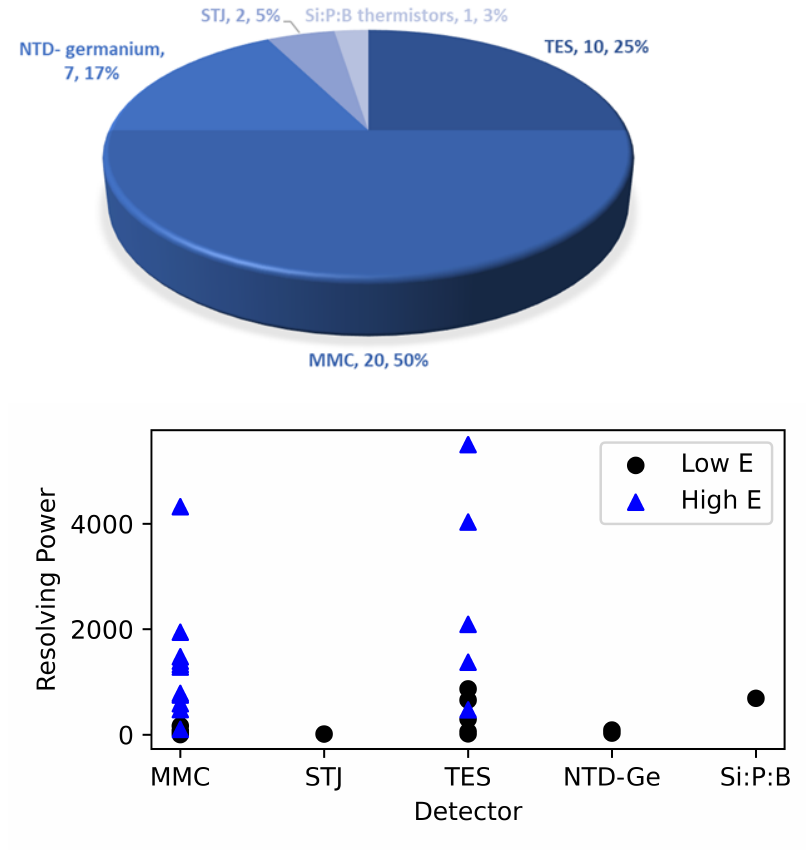
Figure 2. ( Top ) Prevalence of detector use for DES measurements. ( Bottom ) The resolving power is given as a function of detector and it is clear that high energy resolution measurements are not the sole domain of a single detector